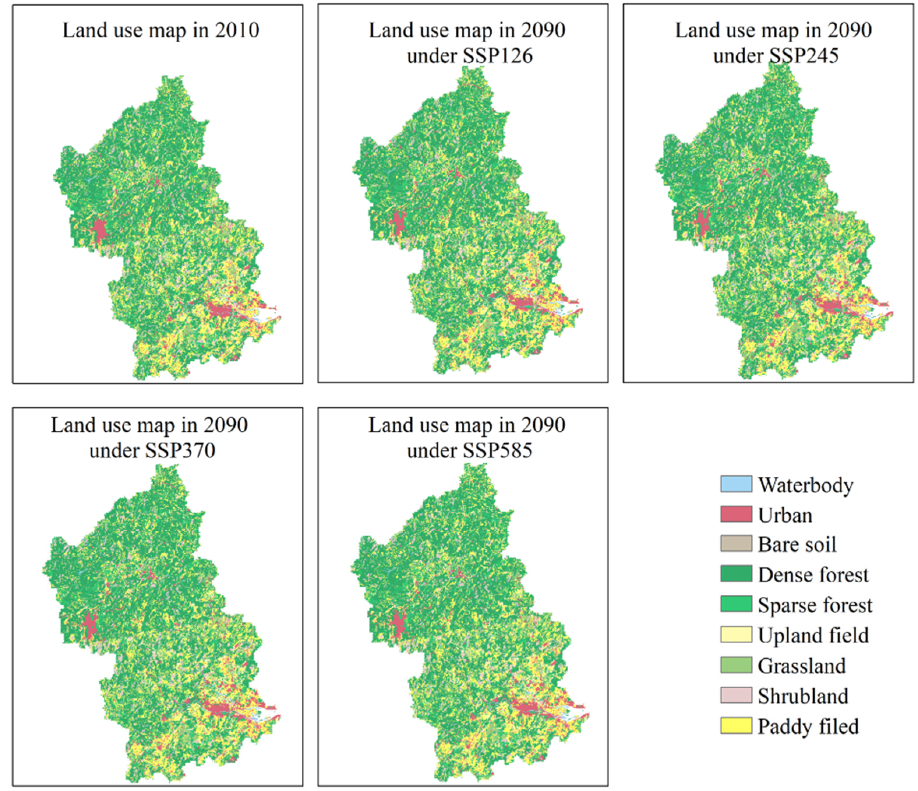
Figure 5. The historical land use maps and the projected land use maps in 2090 under four scenarios.